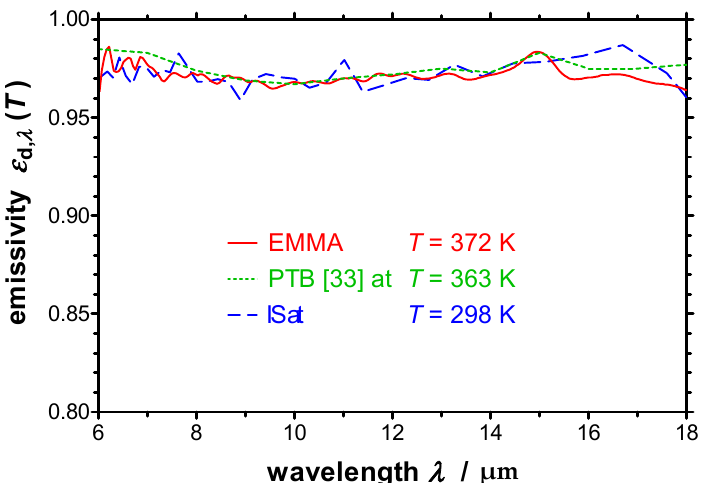
Figure 11. Spectral directional emissivity of a Nextel-Velvet-Coating 811-21 normal to the surface measured with the EMMA at elevated temperature in comparison with the emissivity measured with an integrating sphere (IS) at ambient temperature and with the emissivity measured at PTB [33].